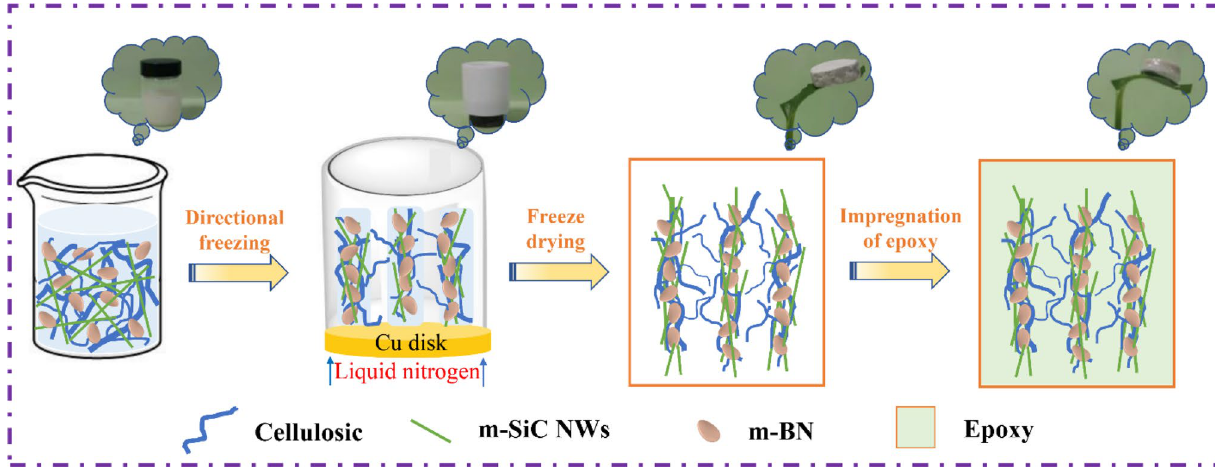
Fig. 3 Schematic diagram of the preparation of